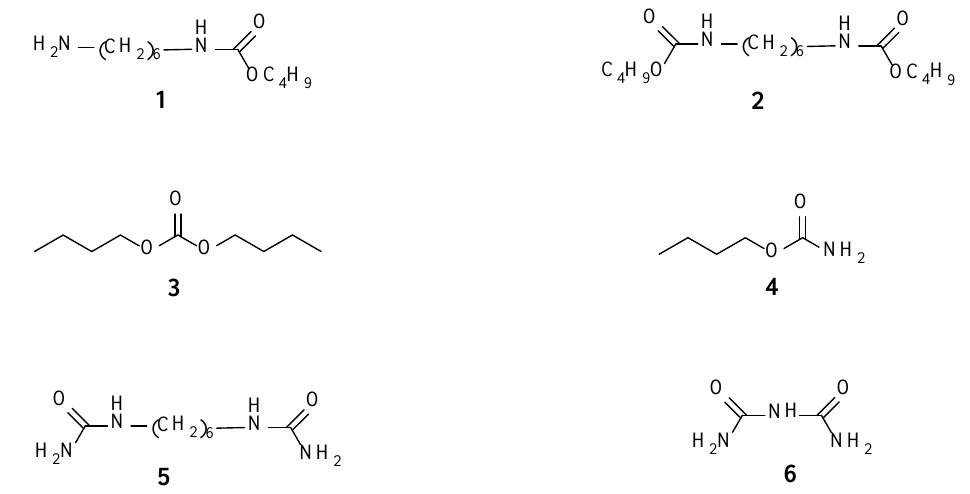
Figure 9. The chemical structural formula of the products for the one-pot synthesis of dibutyl hexane-1,6-dicarbamate from HDA, urea and butanol.